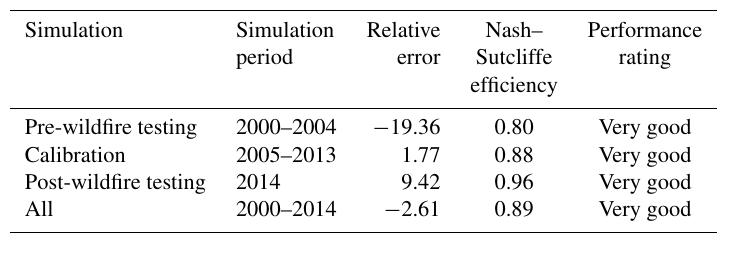
Table 3. Error statistics between observed and simulated monthly streamflows for the calibration period as well as the testing periods. Performance ratings based on Moriasi et al. (2007).